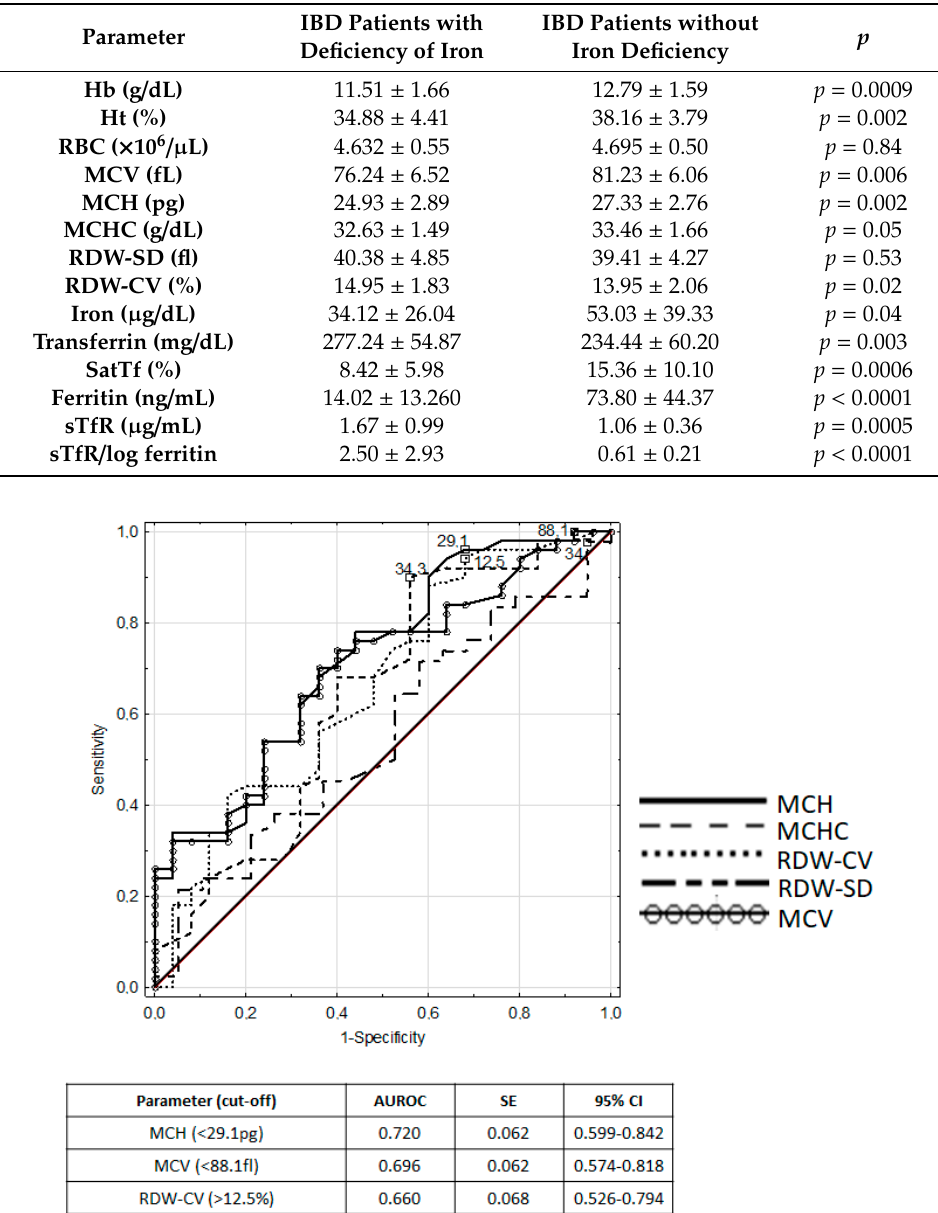
Table 1. Comparison of hematological and biochemical parameters among IBD patients with iron deficiency and normal iron supply.